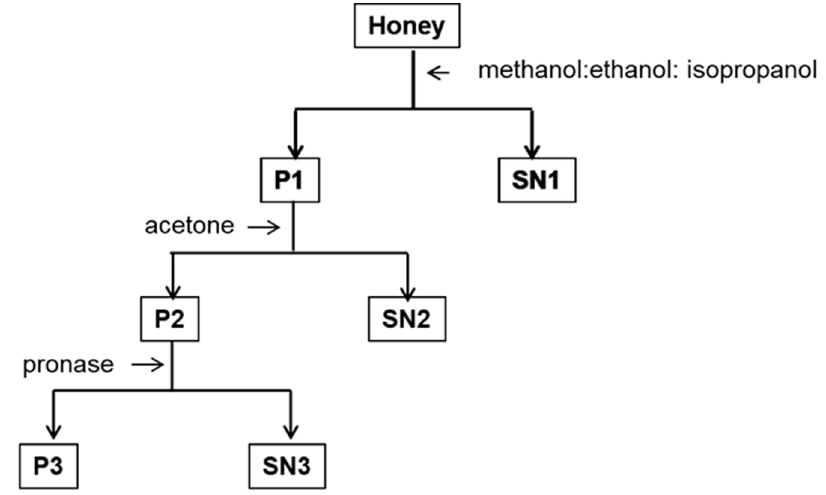
Figure 1. A general outline of liquid–liquid extraction of Figure 1 . A general outline of liquid–liquid extraction of honey.